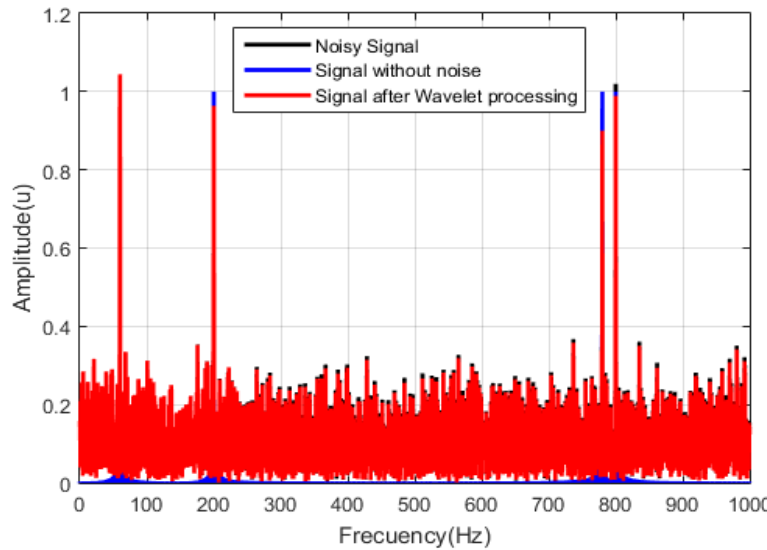
Figure 8. The spectrum of the original signal (blue), the spectrum of the noisy signal (black), and the spectrum obtained after applying the wavelet algorithm for noise reduction.